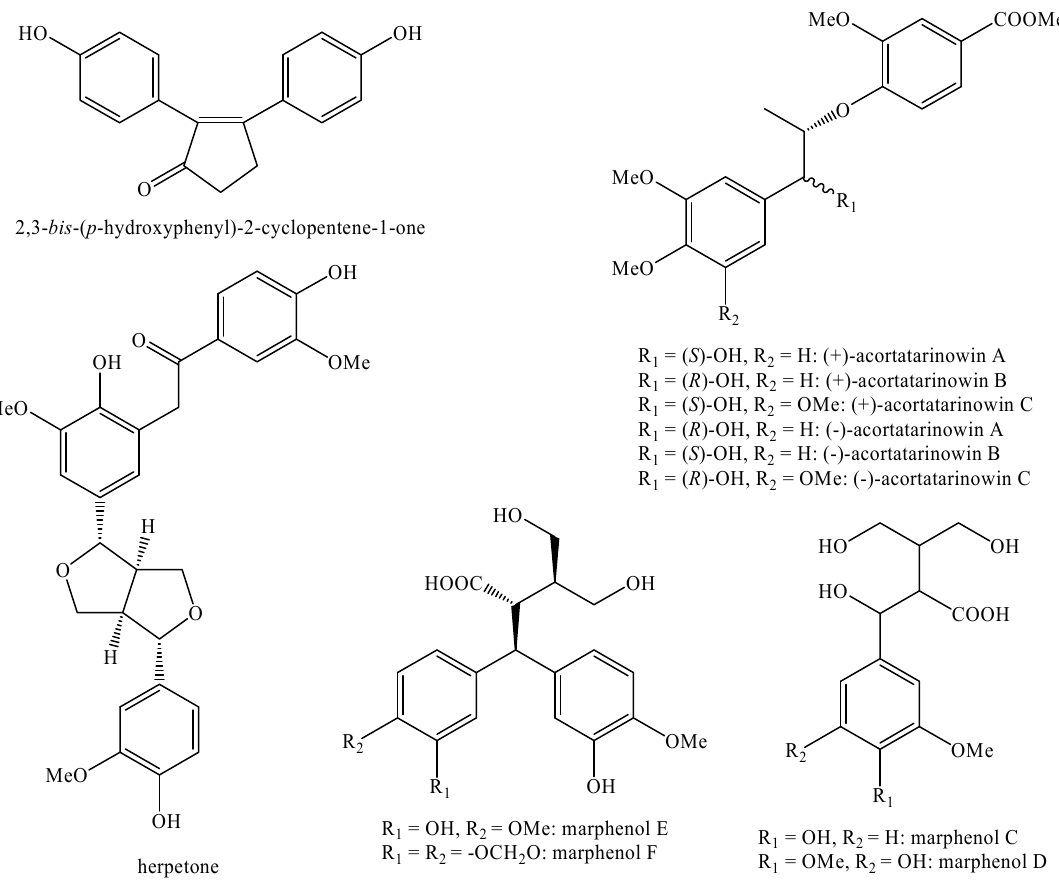
Figure 7. Isolated nor -lignans in the plant kingdom—part 6. Molecules 2020 , 24 , x